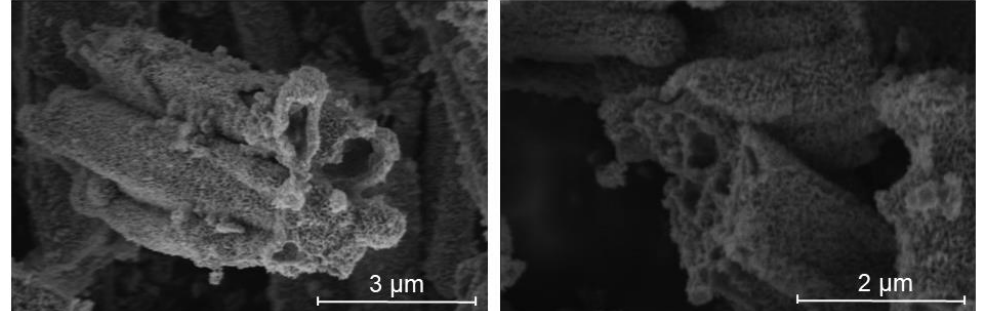
Figure 3. SEM images of TiN tubes.